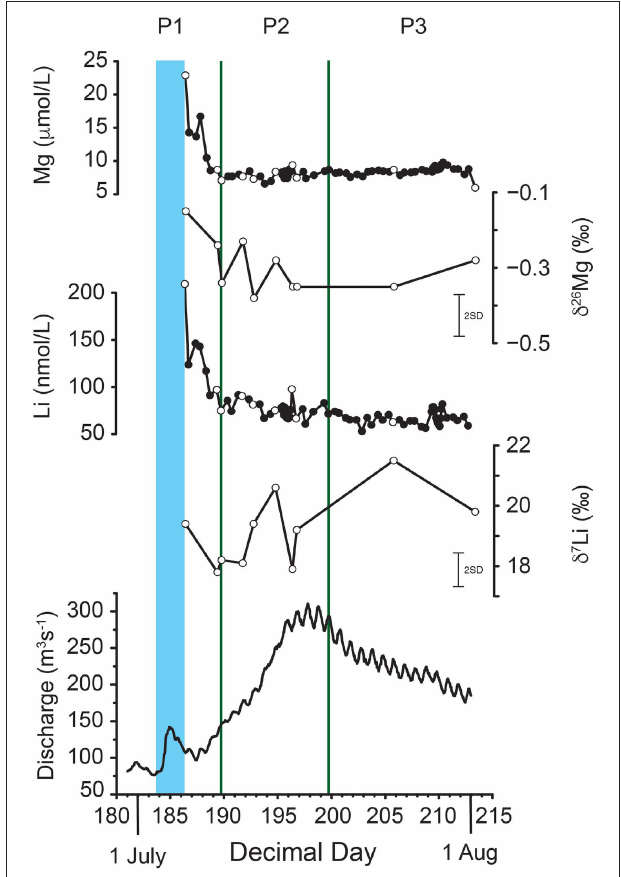
FIGURE 2 | Time series. From top to bottom: Mg concentration, δ 26 Mg, Li concentration, δ 7 Li and discharge. White circles are samples analyzed for this study and black circles are time series data from Hindshaw et al. (2014). The blue band marks the fourth outburst event of 2009 which coincided with the drainage of a supraglacial lake ( Bartholomew et al., 2011). The green lines mark indicate divisions between three hydrological periods (P1, P2, and P3) identified by Hindshaw et al. (2014) based on changes in hydrochemistry. P1 is influenced by the outburst event, P2 is the rising limb of the hydrograph, and P3 the falling